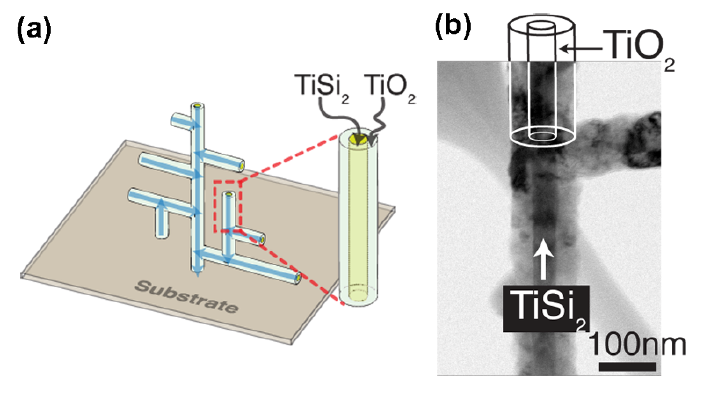
Figure 8. TiO /TiSi heterostructure can be used for water splitting [24]. The structure is 2 2 schematically shown in (a), which is confirmed by TEM imaging. Reproduced with permissions from American Chemical Society